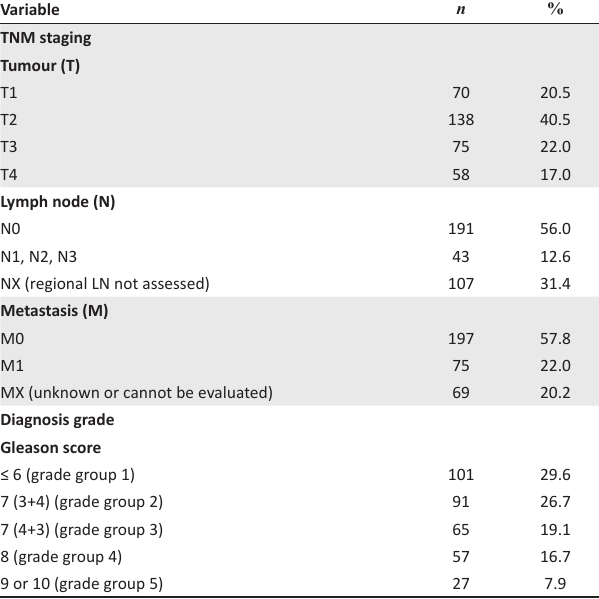
TABLE 6: Associations between PCa severity at diagnosis and participants’ background characteristics and risk factors. Variable